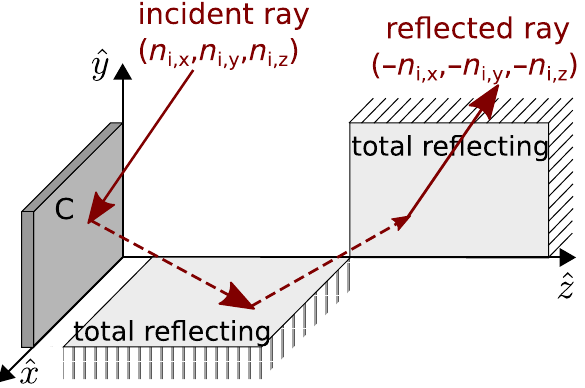
FIG. 9. Schematics of a 3D retroreflector, where three mirrors (two grazing incidence, total reflecting ones and one crystal (C) mirror) are assembled perpendicular to each other. In this way, the reflected ray will always be antiparallel to the incoming one, given it remains in the angular acceptance of the individual mirrors. The sketched angles are strongly exaggerated compared to the real case for better visual